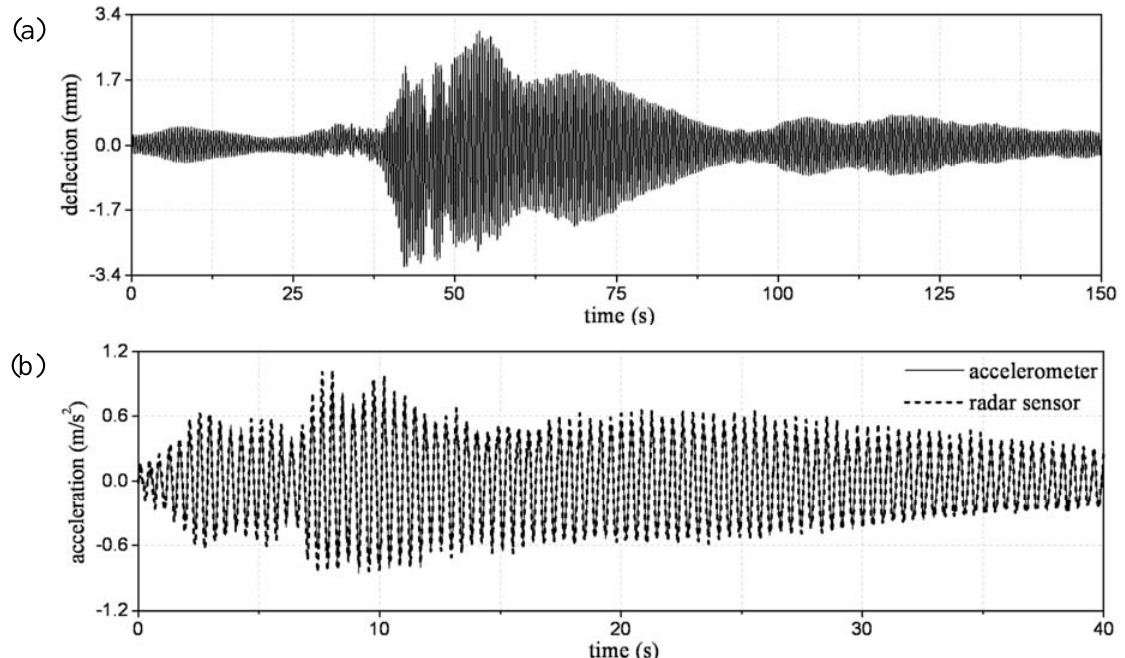
Figure 4. (a) Typical deflection time-history measured by the radar sensor on the stay-cable ; (b) Comparison between the acceleration obtained by accelerometer and radar sensors S' 12 on the investigated